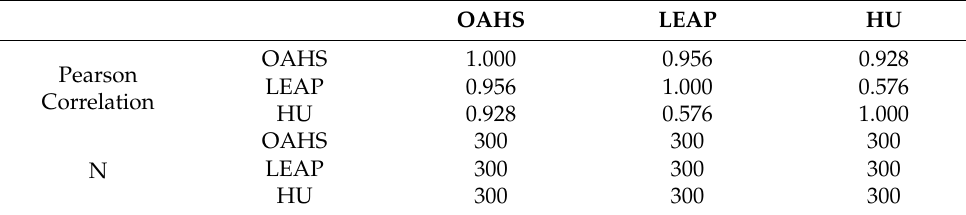
Table 3. Results of Correlation